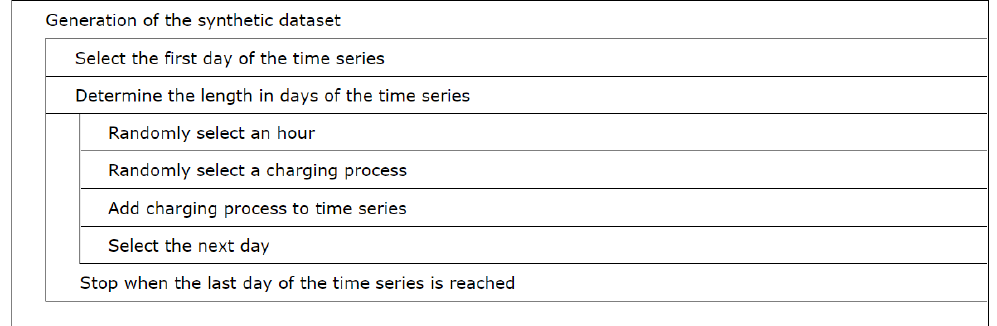
Figure 4. Structure chart of the generation of the synthetic